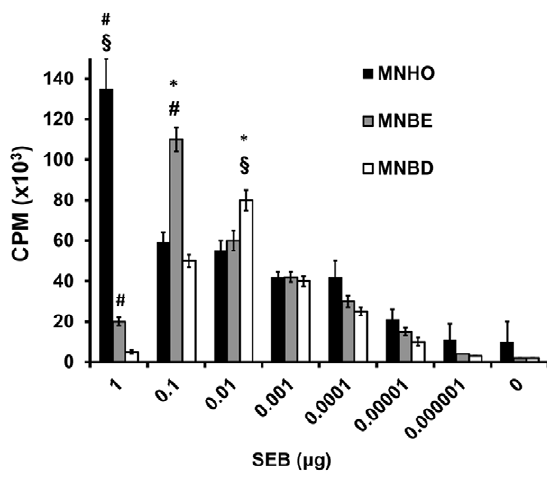
Figure 5. Variant SEB superantigenicity is neutralized by a soluble, high-affinity V b -TCR protein. Human PBMCs were exposed to SEB and varying concentrations of the G5-8 high affinity V b -TCR protein, and subsequently incubated with 3 H-thymidine. Cellular proliferation is reported as the measure of the counts per minute of 3 H-thymidine that had incorporated into the DNA of the PBMCs. Error bars represent the standard deviations, and statistical significance was determined by using Student’s unpaired t -test. *, P , 0.05 for statistically significant differences with respect to toxin alone.